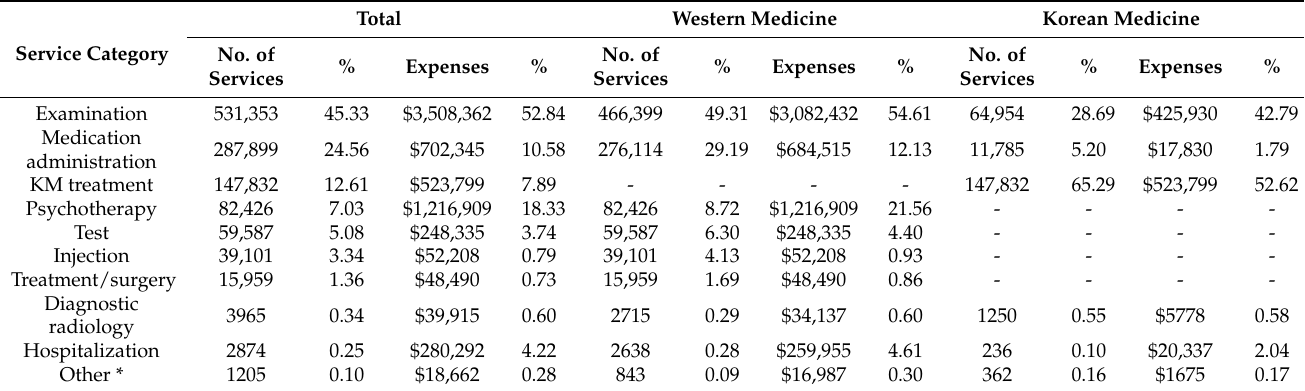
Table 3. Number of medical services and medical expenses per